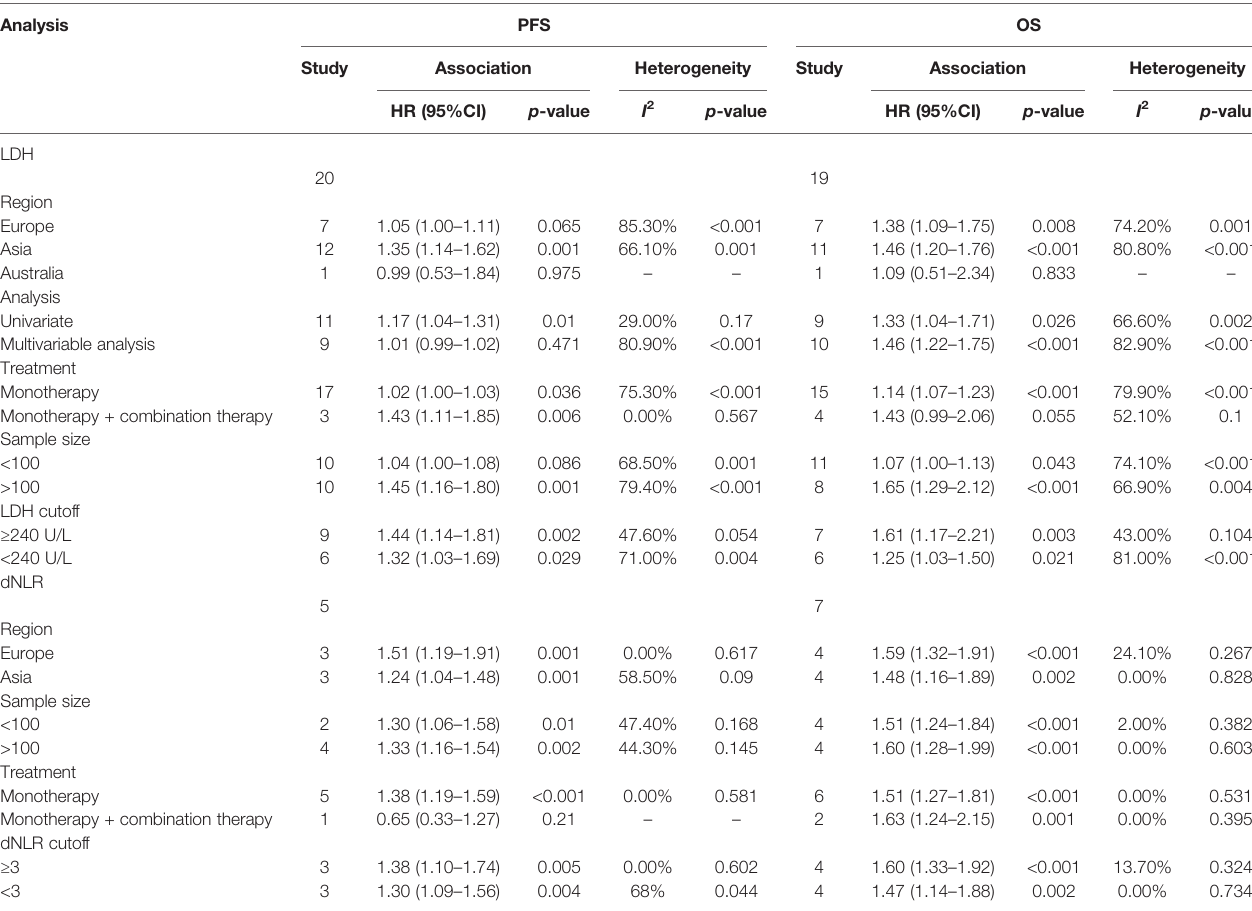
TABLE 2 | Subgroup analysis.